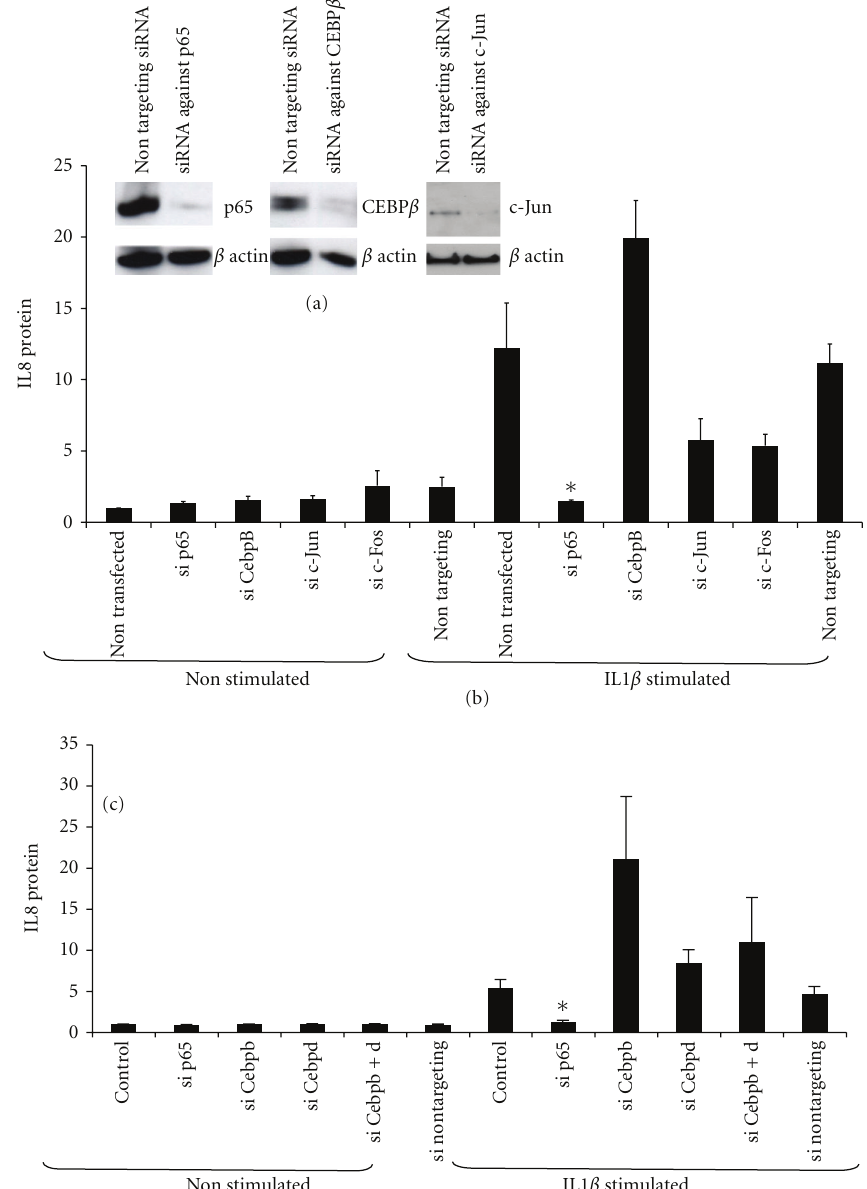
Figure 3: (a) siRNA knockdown of p65 (a), CEBP β (b), and c-Jun (c). (b) The e ff ects of siRNA against NF κ Bp65, CEBP β , c-Jun, and c-Fos on IL8 protein production in a nonstimulated and IL1B-stimulated state. Data is normalised to the nontargeting control. Data are presented as mean ± SEM ( n = 4). An ANOVA was performed with a Dunnett’s multiple comparison post-test. ∗ Indicates a significant di ff erence of P less than 0.05. (c) The e ff ects of siRNA against NF κ Bp65, CEBP β , and CEBPD on IL8 protein production in a nonstimulated and IL1B- stimulated state. Data is normalised to the non-targeting control. Data are presented as mean ± SEM ( n = 4). An ANOVA was performed with a Dunnett’s multiple comparison post-test. ∗ Indicates a significant di ff erence of P less than